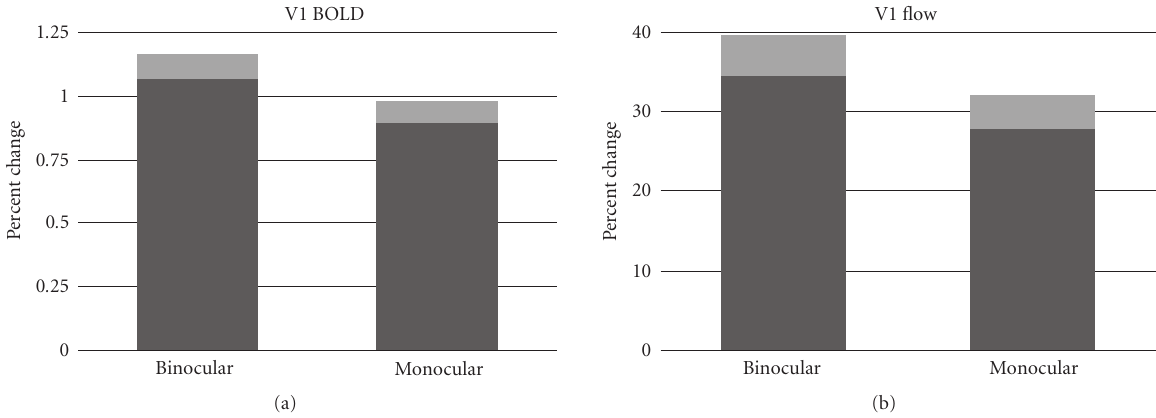
Figure 3: Percent change ( ± SE in lighter shade of gray) in BOLD and CBF signals in response to binocular and monocular stimulation. Responses evoked by binocular stimulation are significantly greater than those produced by monocular